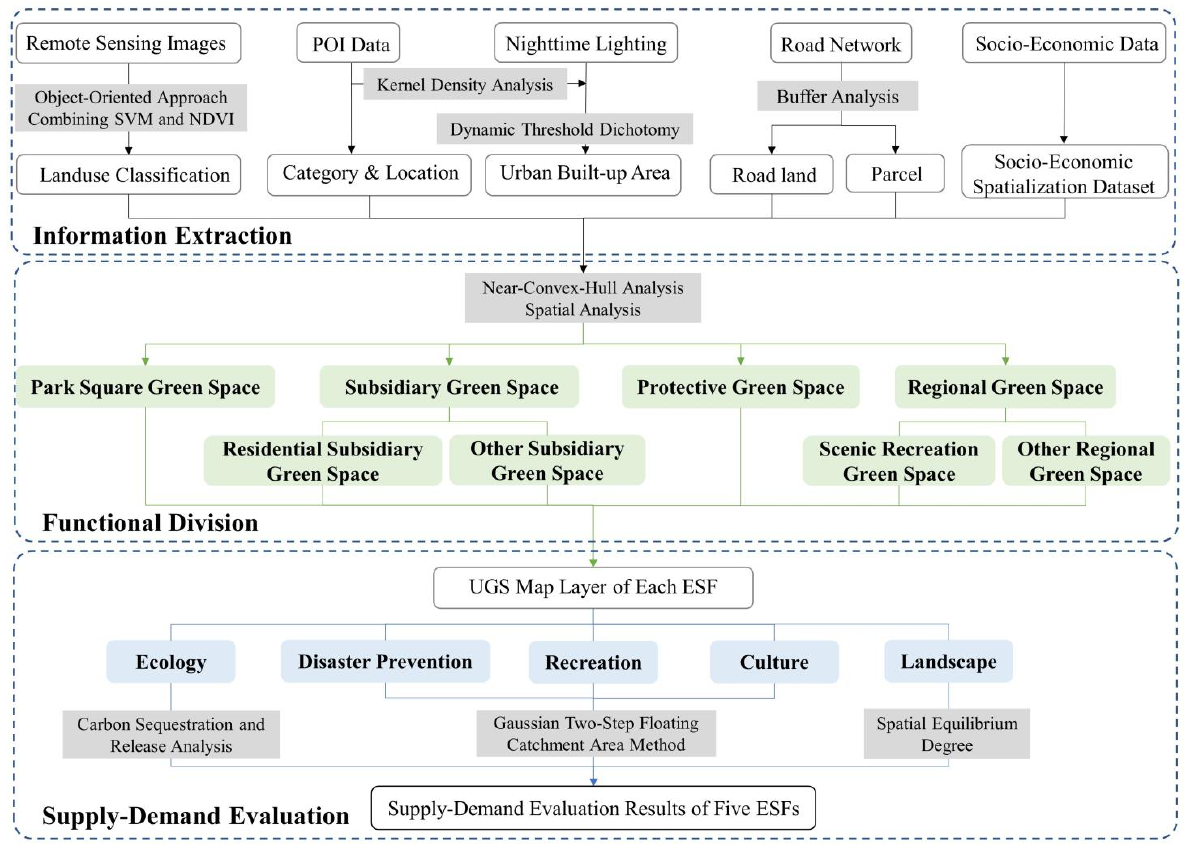
Figure 1. Framework diagram for the study.